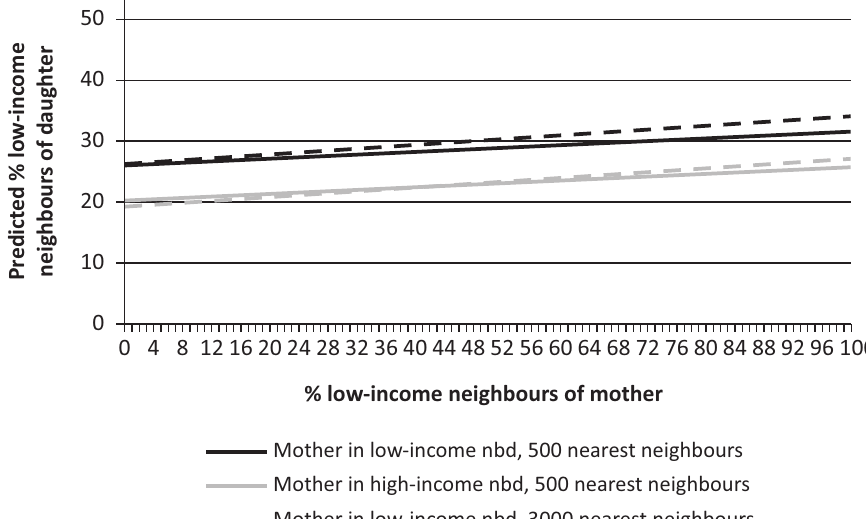
Figure 3. Predicted share low-income neighbours of daughter by share low-income neighbours of grandmother, for an indi- vidual of mean age, income and distance to mother/grandmother, mode education level and family status. Notes: Mother in high- or low-income neighbourhood, varying scale; strategy